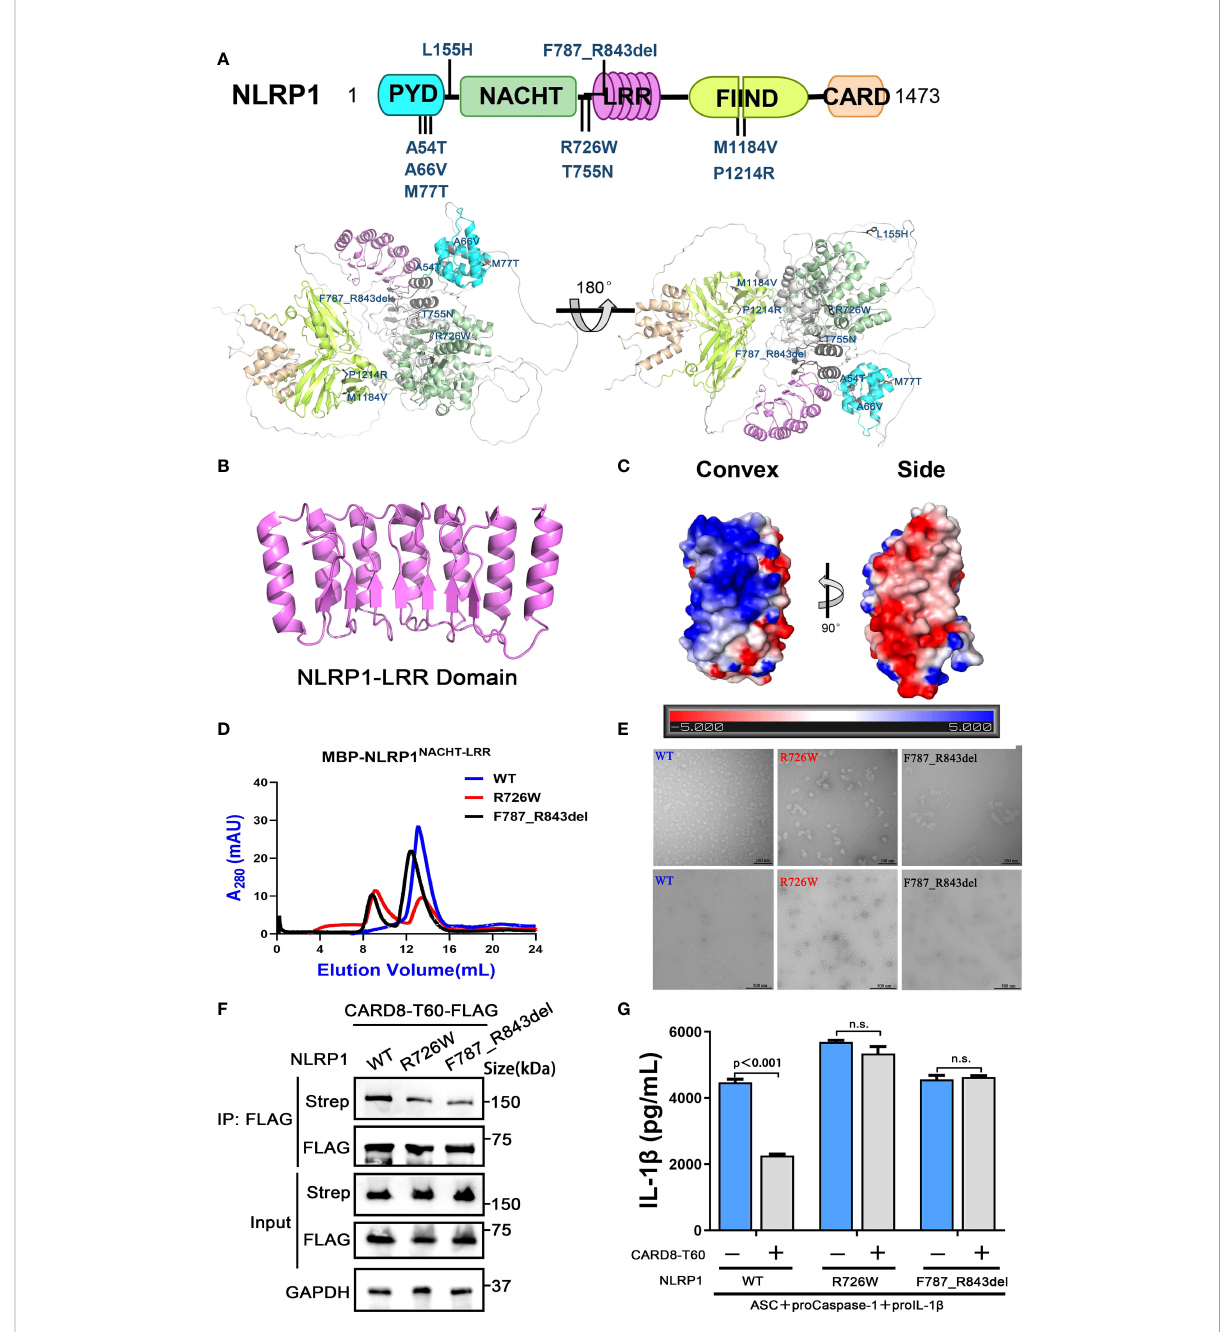
FIGURE 6 The disease-causing mutations cause decreased interaction between NLRP1 and CARD8. (A) The disease-causing mutations in autoimmune- in fl ammatory diseases are indicated on the predicted structure of full-length NLRP1. (B) Monomer crystal structure of LRR domain of NLRP1. (C) The electrostatic charge surfaces analysis of NLRP1 LRR . The electrostatic potential of the convex and side of NLRP1 LRR was calculated by APBS. (D) Gel fi ltration characterization of recombinant MBP-NLRP1 NACHT-LRR , R726W mutant and F787_R843del mutant proteins. (E) Representative negative-stain electron microscopy snapshots of recombinant MBP-NLRP1 NACHT-LRR , R726W mutant and F787_R843del mutant proteins. (F) HEK 293T cells were transiently transfected with constructs for NLRP1-Strep, NLRP1-R726W-Strep mutant, NLRP1-F787_R843del- Strep mutant and CARD8-T60-FLAG. After 28 hours, the protein expression was detected by immunoblotting, and